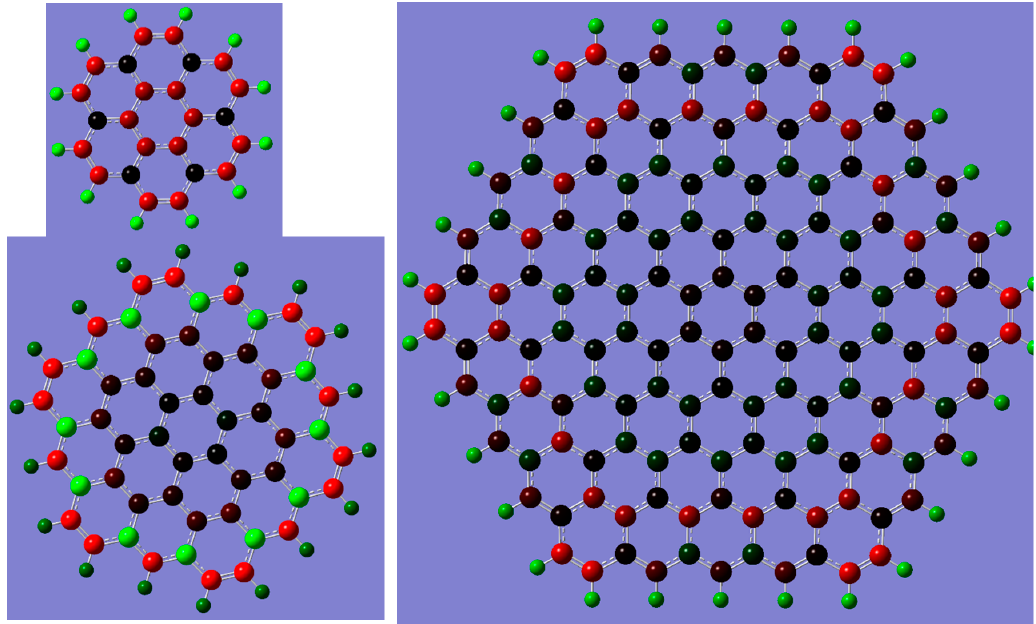
Figure 1. The positions of the benzene ring over the graphene sheet.